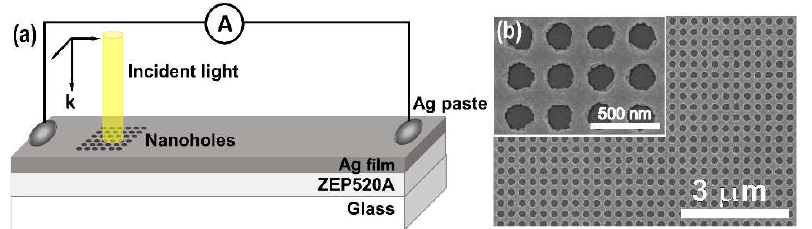
Figure 1. Ag thin-film detector concept and nanostructure. ( a ) Schematic of the Ag thin-film photodetector, and ( b ) top-view scanning electron microscopy (SEM) images of the periodic plasmonic nanohole arrays. The inset in ( b ) is a magnified image of a section of the image in the main panel.